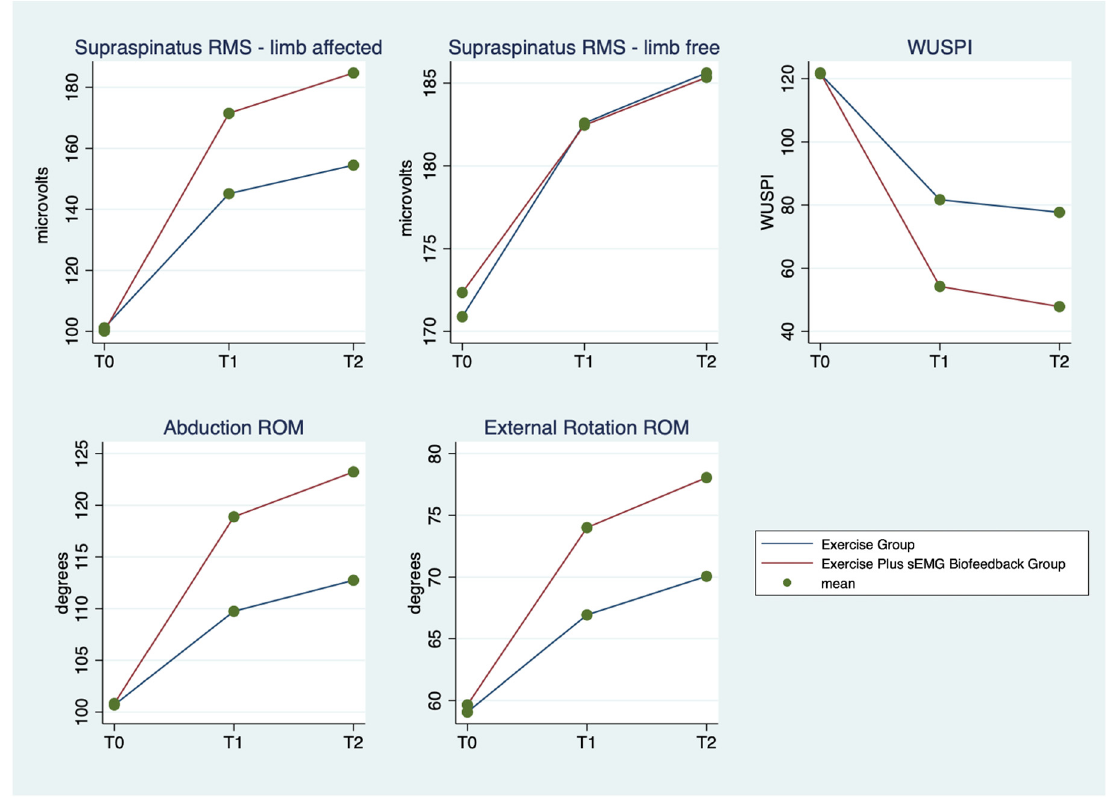
Figure 1. Outcomes’ mean scores by group and detection time. Table 3. Time effect at each treatment